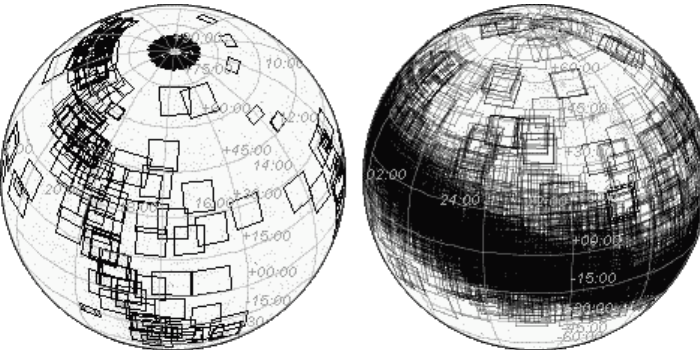
Fig. 1. The distribution of the photographs on the celestial sphere, obtained within the projects “G. A. Shajn’s Plan” (left panel) and “Crimean Survey of Minor Planets” (right panel).